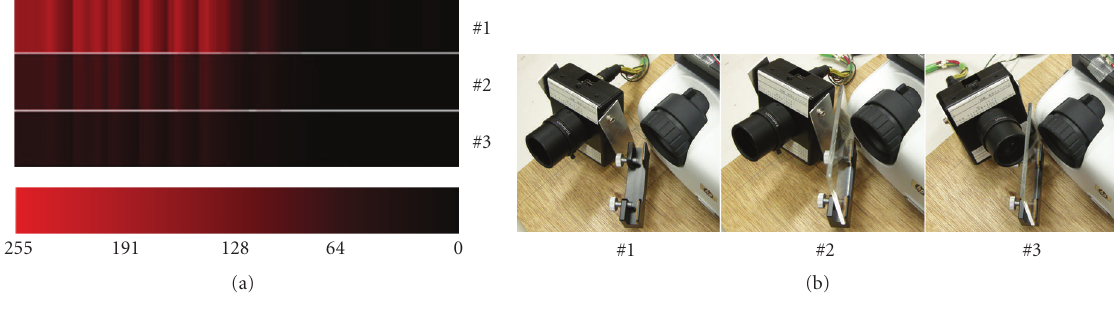
Figure 8: Red intensities seen by the camera in three di ff erent setups.